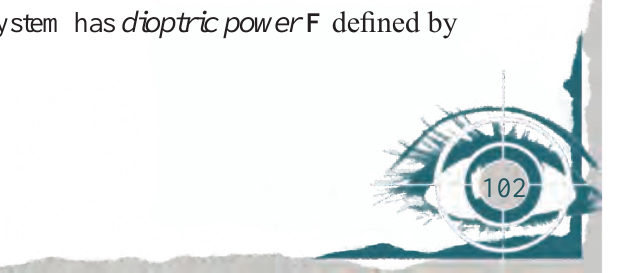
and T and the gap between T 0 1 immediately after the thin 1